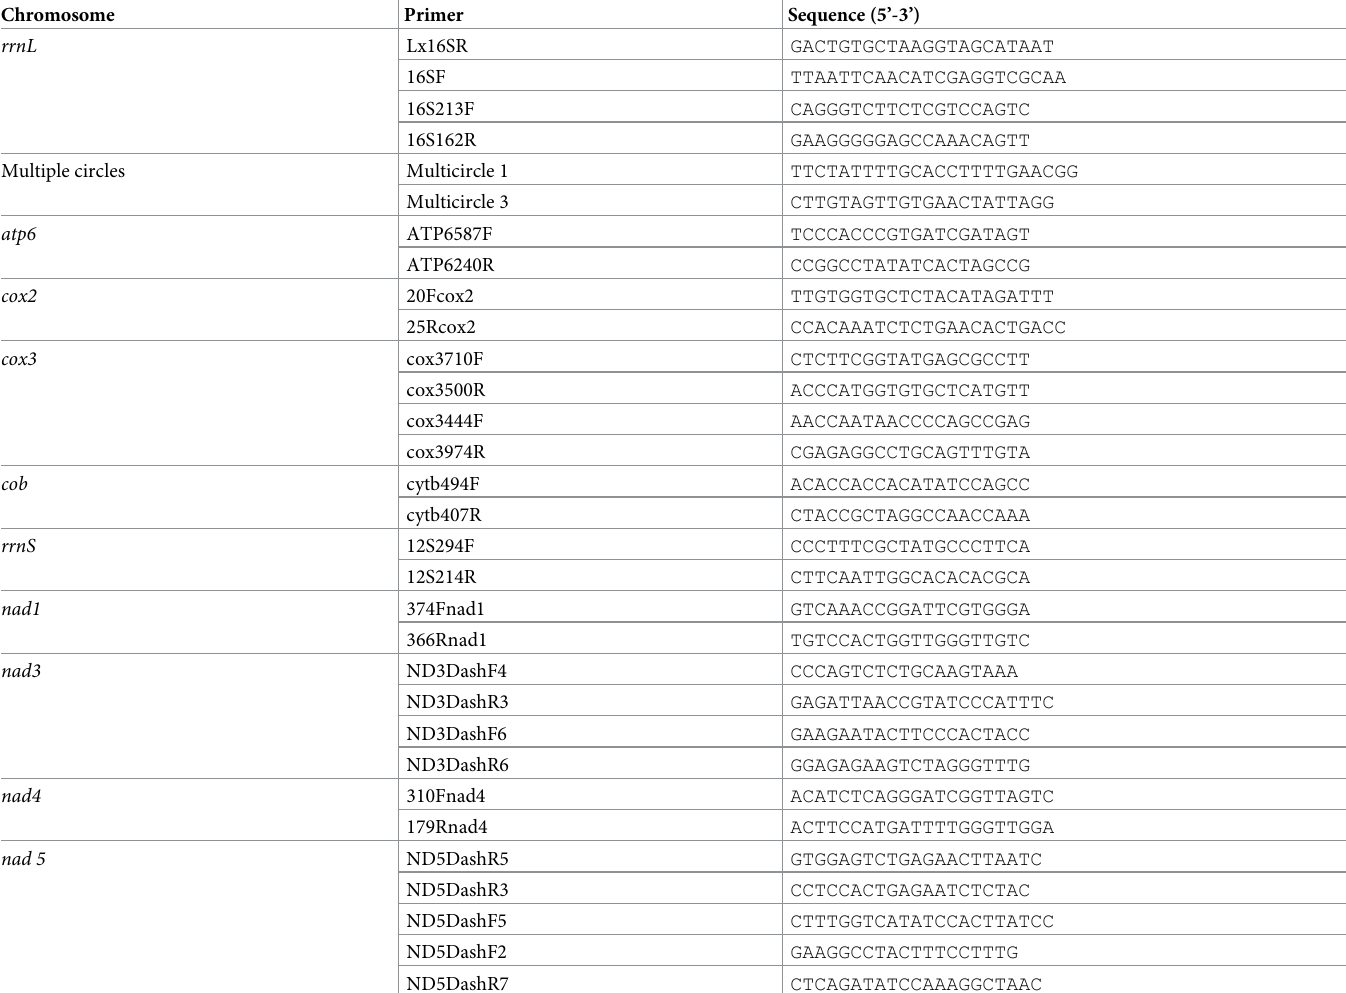
Table 1. Primers (5’ ! 3’) used to generate mitochondrial sequences of Geomydoecus aurei .